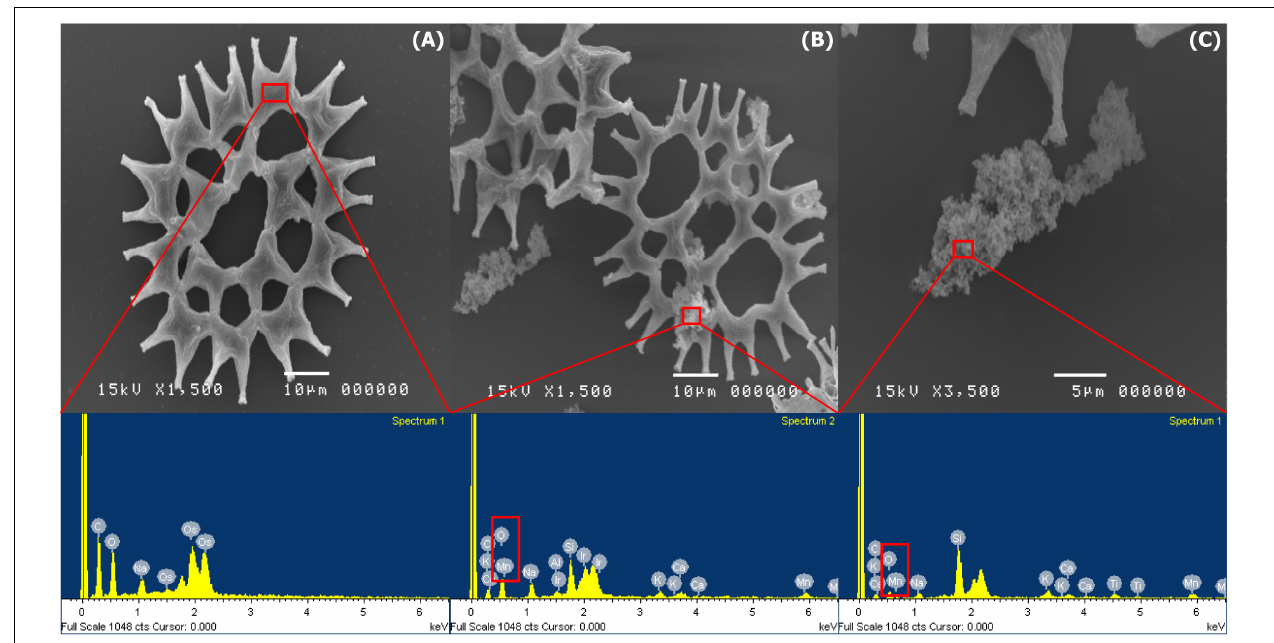
FIGURE 3 | SEM microphotographs and EDS spectrums of BioMnO x on the cell surface of P. duplex AARL G060. (A) Control and EDS spectra of selected area on cell surface. (B,C) Microalga cell and aggregate of BioMnO x in culture and EDS spectra of selected area on day